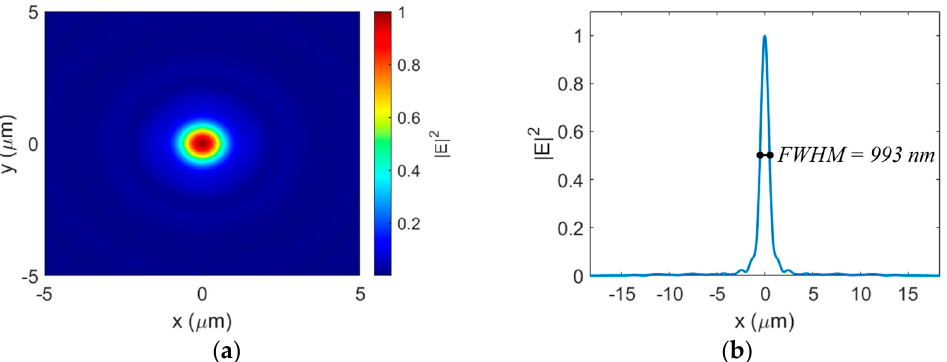
Figure 8. ( a ) Normalized electric field intensity distribution at the focal plane with circularly polarized light. ( b ) Focal spot cross-section for circular polarization.